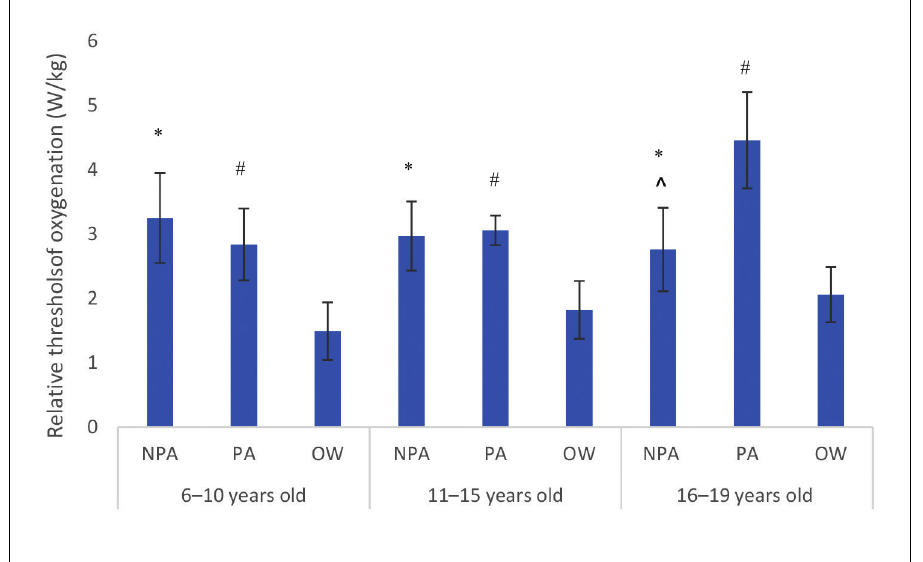
Figure 3. Relative threshold